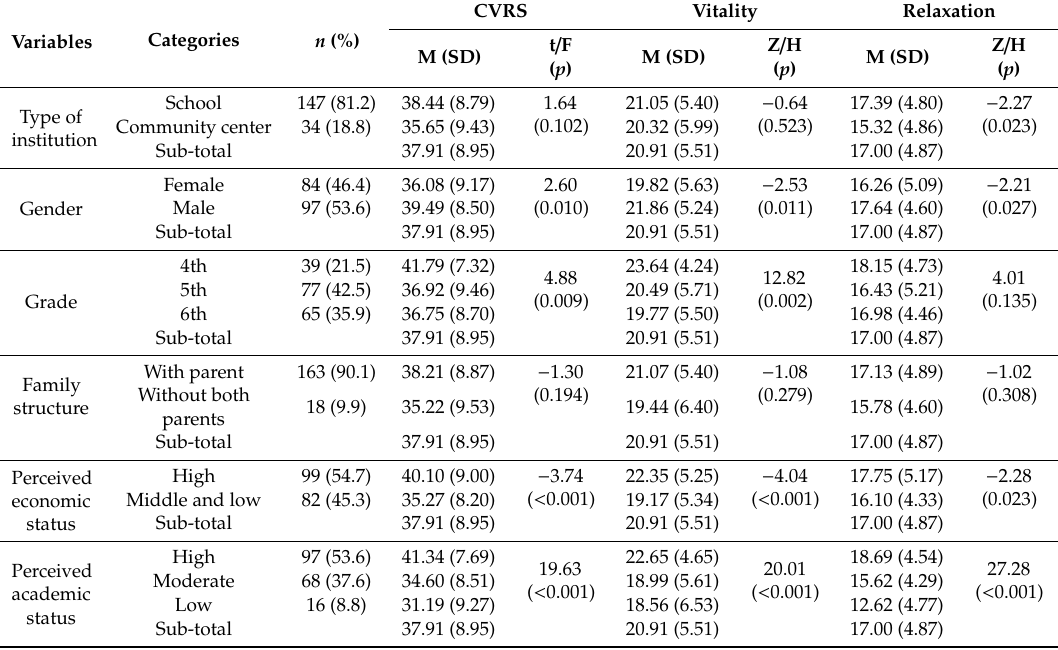
Table 1. General characteristics of the participants and score of CVRS ( n =